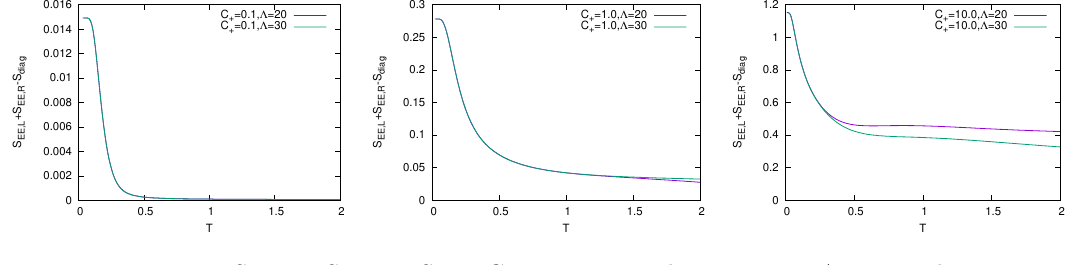
Figure 7 . S EE , L + S EE , R − S diag , C + = 0 . 1 , 1 . 0 and 10 . 0 , ω = 1 , Λ = 20 and 30 .